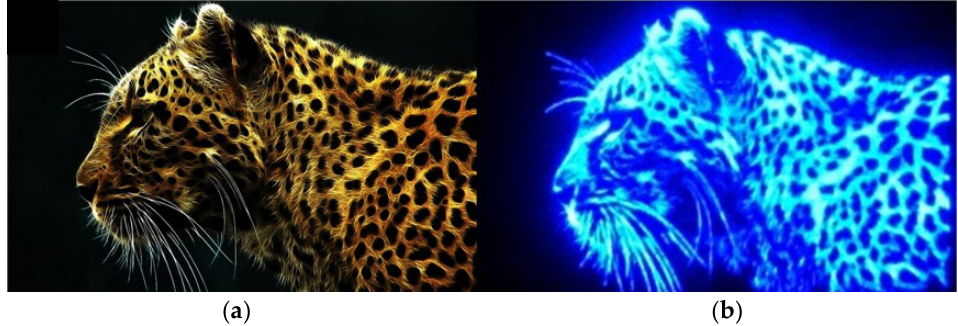
Figure 8. The original image ( a ) of a high resolution leopard and its corresponding image ( b ) on the 1920 × 1080 blue micro-display.